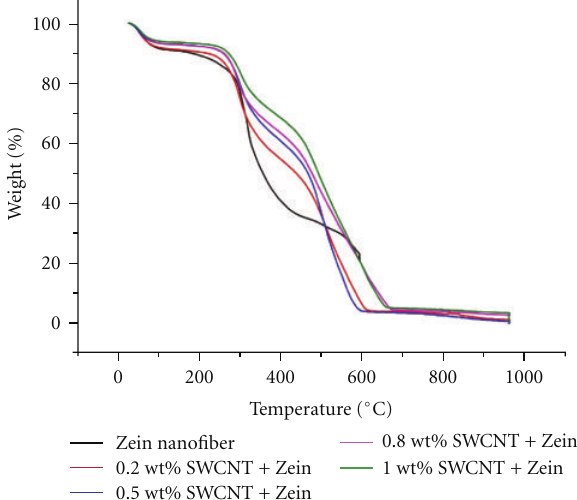
Figure 3: TGA thermograms of the zein nanofiber, zein-SWCNT nanocomposite sca ff